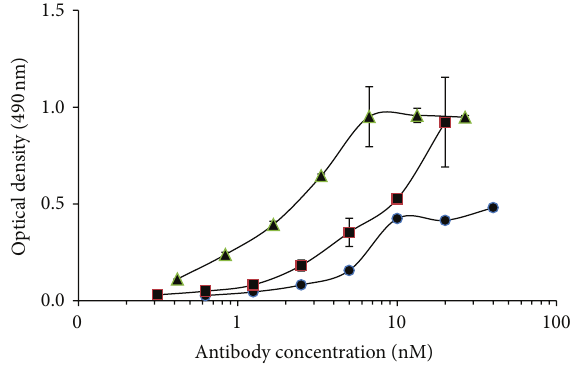
Figure 2: Immunoreaction of F240 × 14A8 Bi-Fab with gp41. Immunoreactivity of Bi-Fab antibody constructs with HIV antigen gp41. Antigen gp41 was coated at 2 𝜇 g/mL in PBS; the serial dilutions of Bi-Fab antibodies (Bi-Fab A, e , and Bi-Fab B, ◼ ) compared to that of serial dilutions of F240 antibody ( 󳵳 ); the reaction was developed by HRP-conjugated protein L (1: 20,000) and measured by optical density at 490 nm. Results are representative of three different experiments and each experimental point is the mean ± standard deviation of triplicate